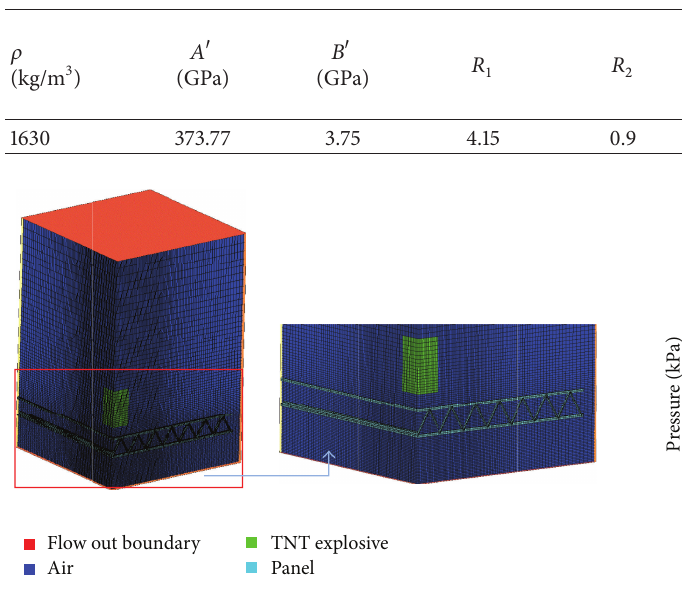
Figure 2: View of three-dimensional finite element model and high-resolution view of the field around sandwich panel. (For interpretation of the references to colour in this figure legend, the reader is referred to the web version of this paper.)